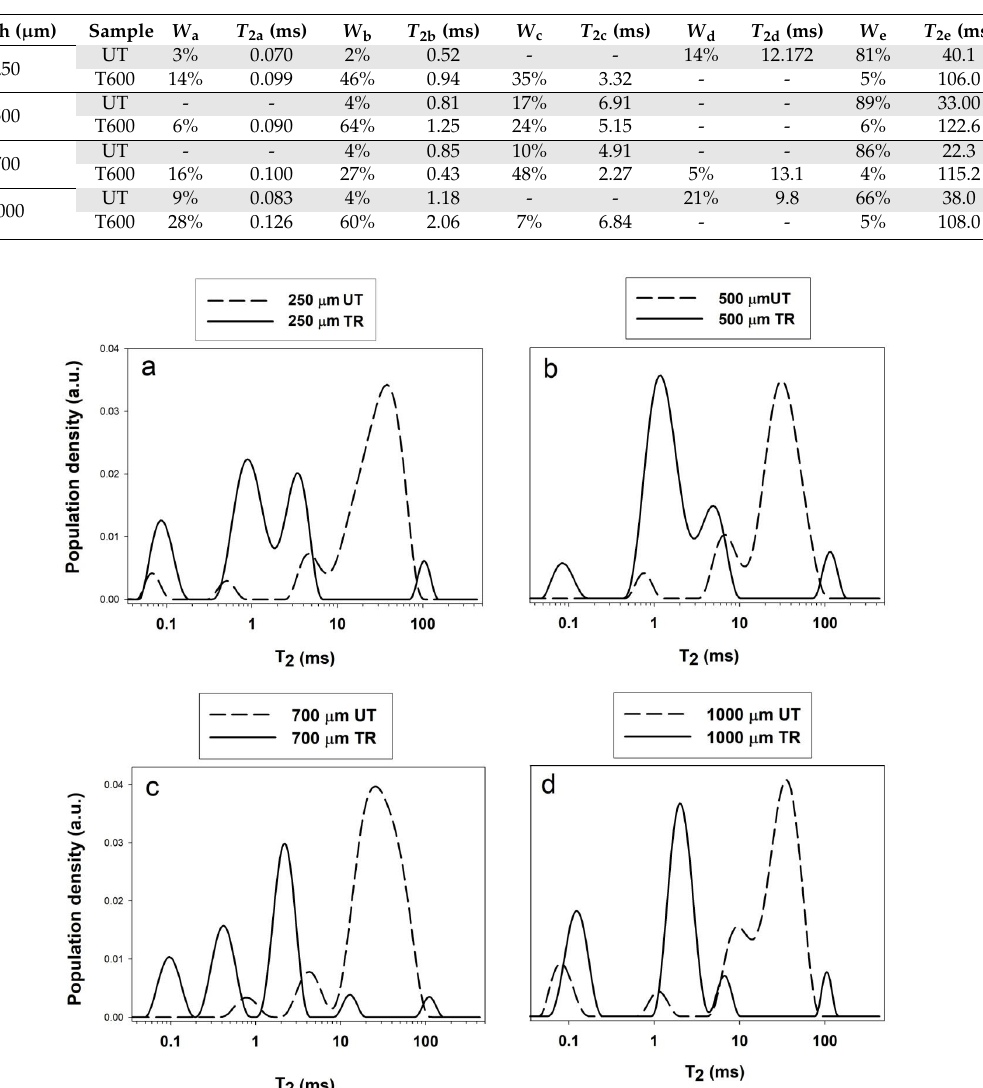
Figure 10. T 2 relaxation time distributions in untreated calcarenite (dashed lines) and calcarenite treated with TEOS for 600 s (solid lines) at 250 μm ( a ); 500 μm ( b ); 700 μm ( c ); and 1000 μm ( d ) of depth.